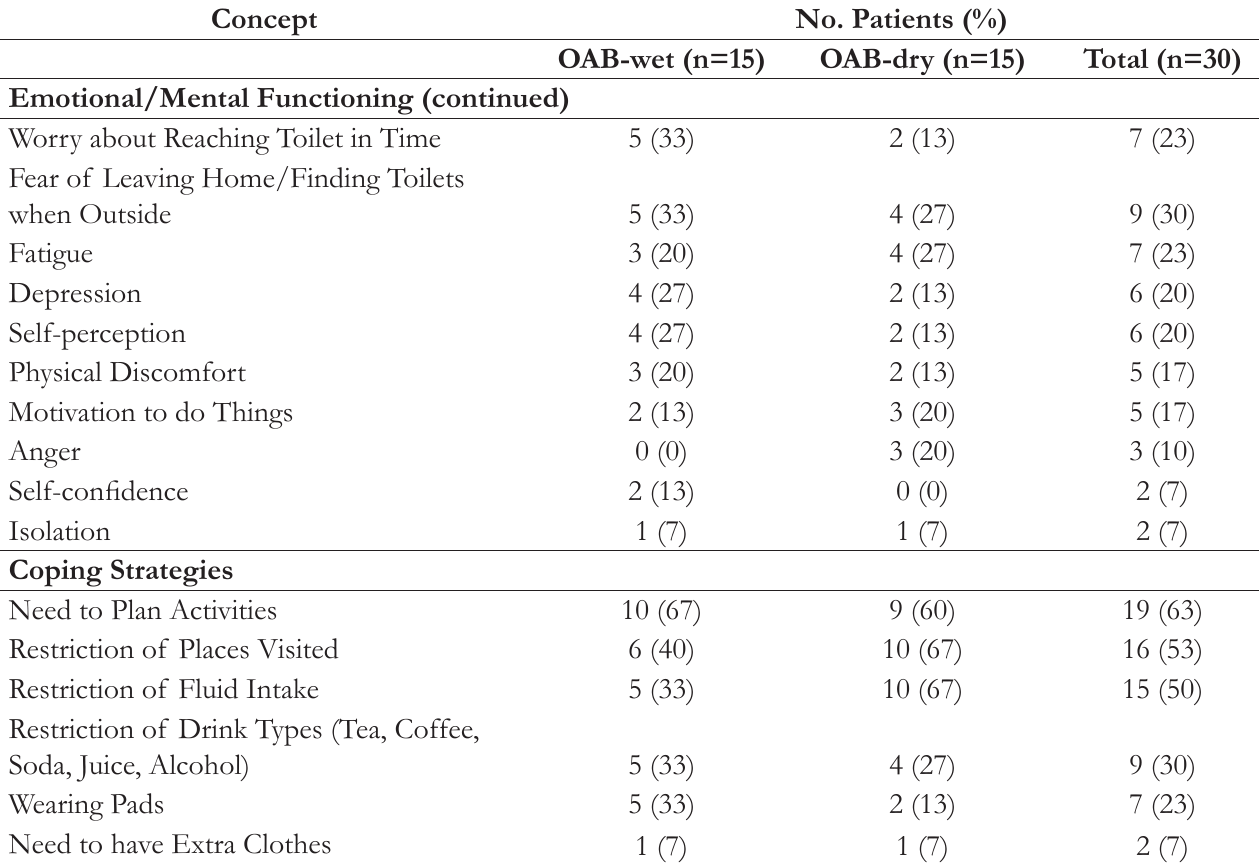
Table 3. Factors Affecting Quality of Life in Patients with OAB (Reported by >5% of Patients) Concept